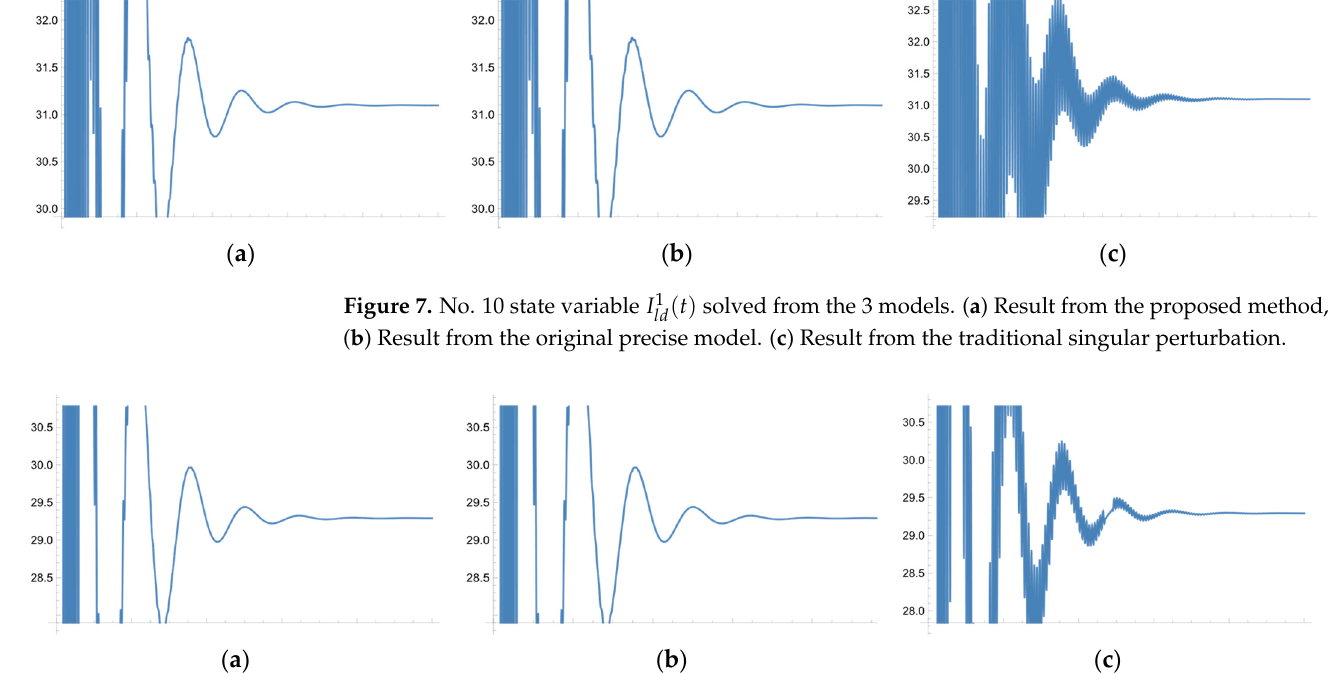
Figure 7. No. 10 state variable I ld 1 ( t ) solved from the 3 models. ( a ) Result from the proposed method, ( b ) Result from the original precise model. ( c ) Result from the traditional singular perturbation.